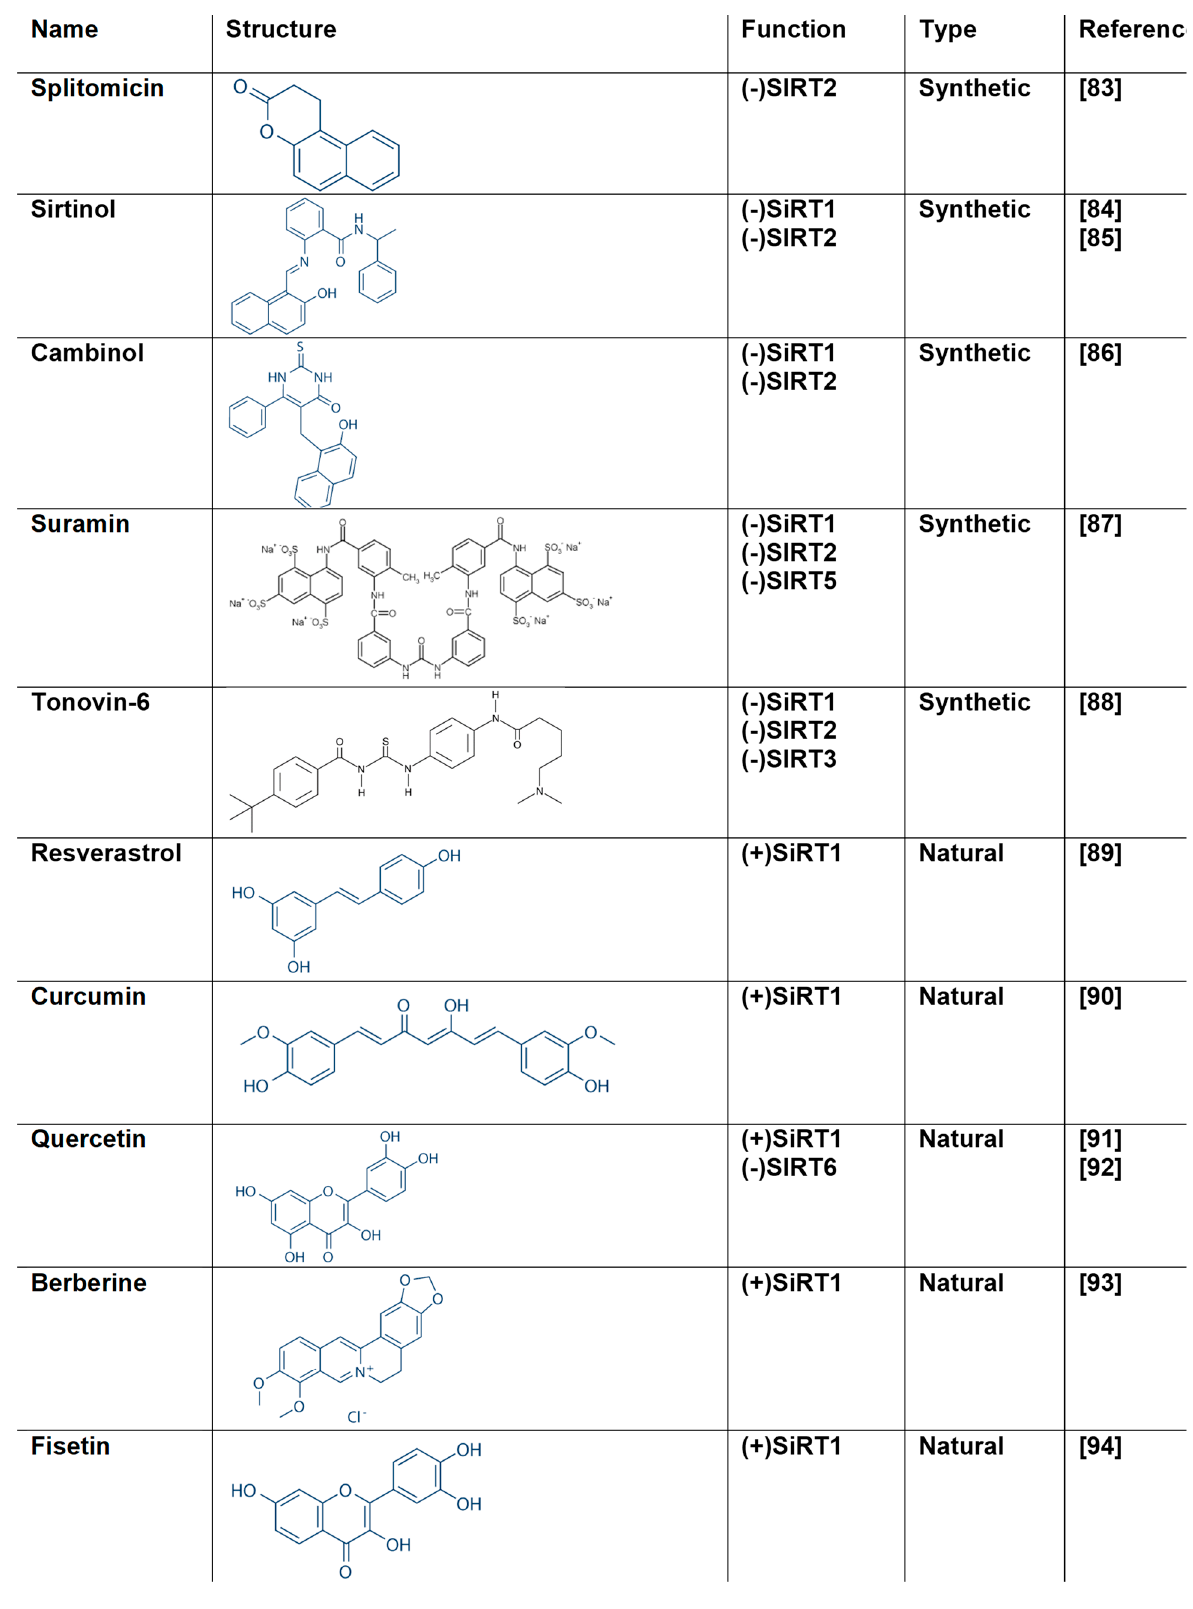
Figure 6. The structure of natural and synthetic SIRT modulators [83–94].